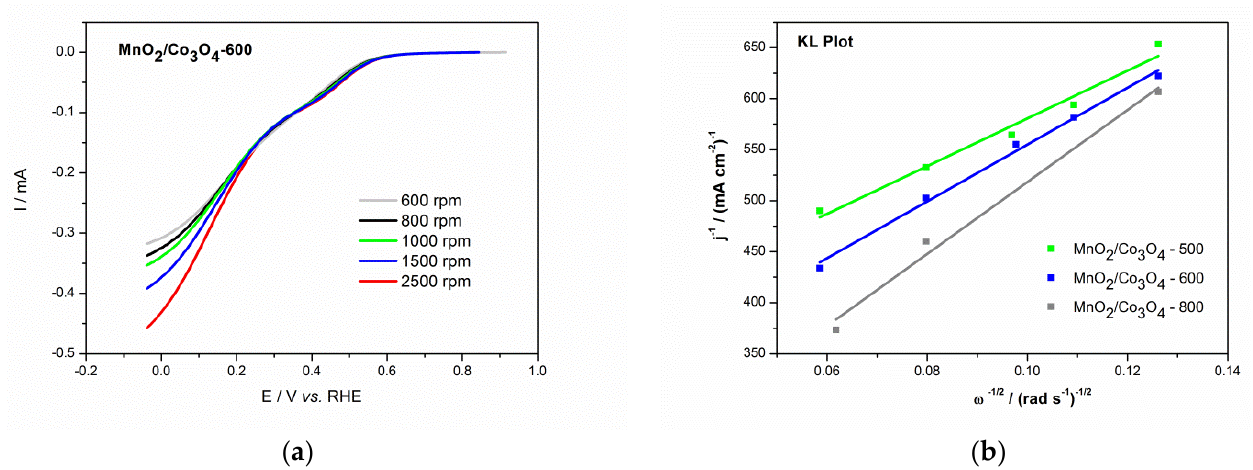
Figure 6. LSV performance of synthesized materials: MnO 2 /Co 3 O 4 -600 ( a ) at different electrode ro- tation rates; ( b ) KL-plot of the synthesized materials; 0.1 M KOH, O 2 atmosphere. rotation rates; ( b ) KL-plot of the synthesized materials; 0.1 M KOH, O